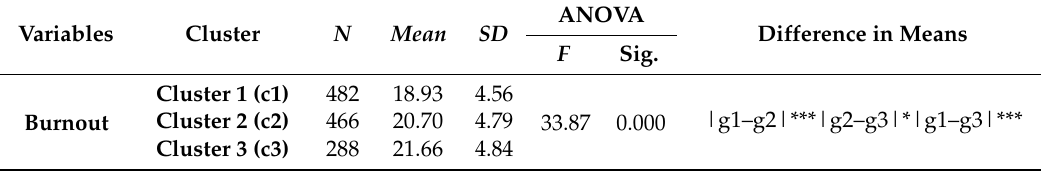
Table 3. Burnout and personality profiles. Univariate analysis of variance and post hoc.